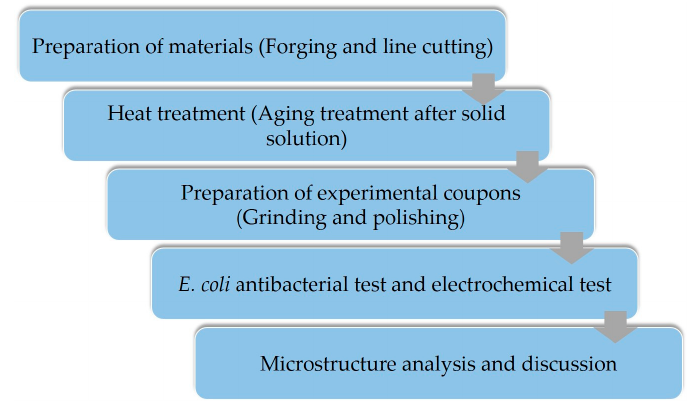
Figure 1. Flowchart of the experimental procedure.